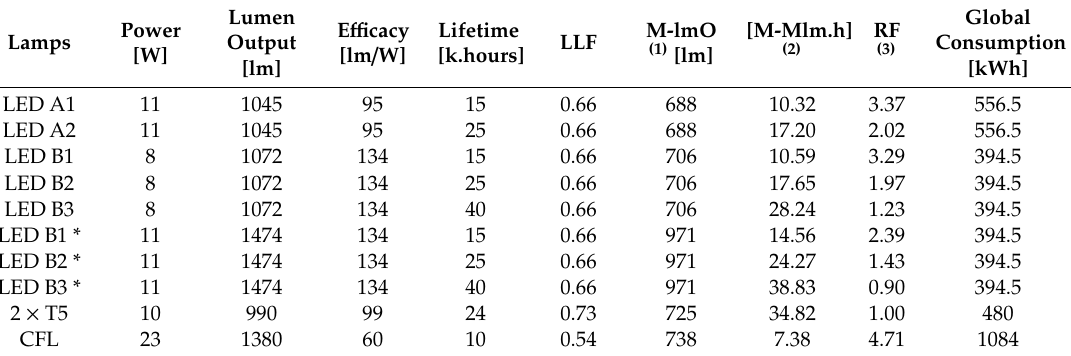
Table 6. Performance parameters for